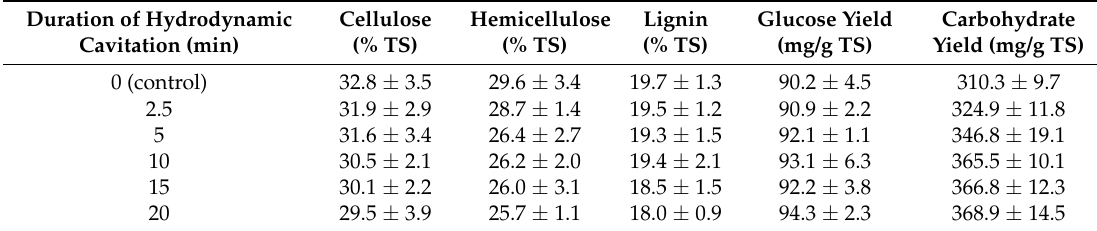
Table 1. The composition of the substrate before and after pretreatment, and the amount of glucose and carbohydrate released to the liquid phase of the substrate. TS—total solids.